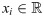
Converting persistence diagram to a 1D density function.We convert persistent points in the persistent diagram Dgf in (A) into a set of weighted points in the line as shown in (B). We then put a Gaussian function mi ⋅ Kt(xi, ⋅) at each point xi∈R, and the sum of them gives the function ρD. Note that a point with lower persistence (such as (x7, y7 − x7)) has less contribution to the final density function ρD.